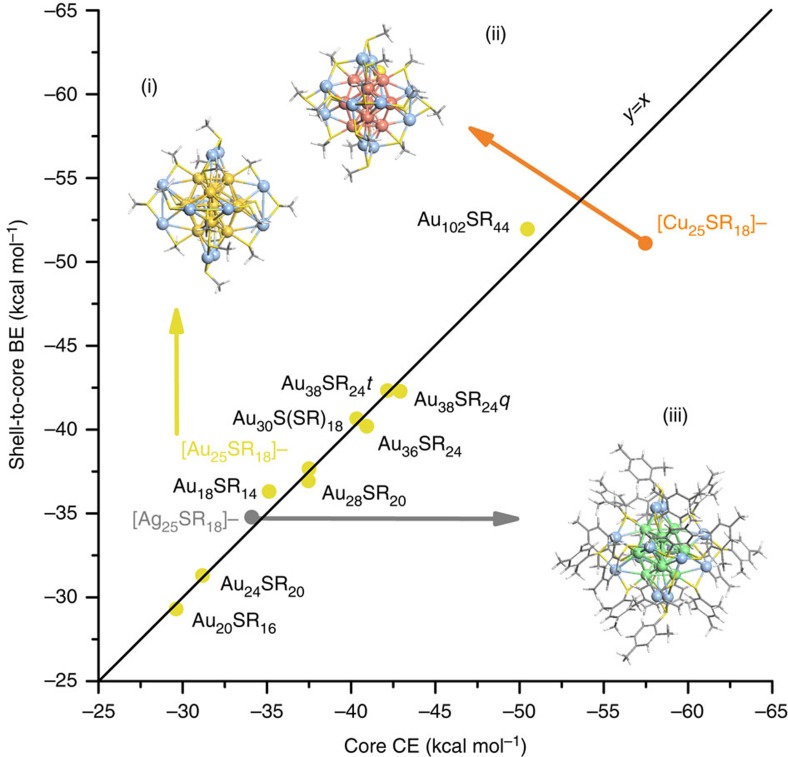
Parity between core cohesive energy and the shell-to-core BE.The corresponding structures of the Aun(SR)m NCs are presented in Fig. 1 except from the optimized structures of (i) [Au25SR18]− (ref. 31), (ii) [Cu25SR18]− and (iii) [Ag25(SPhMe2)18]− (ref. 36) NCs, which are shown as insets in the graph. For i–iii, nc=13 metal atoms (Au/Cu/Ag) and nShellInt=12 as in Fig. 1. The shell metal atoms are shown in blue, whereas, the Cu and Ag core metal atoms are shown in red and green, respectively. Here, all the Au and Ag NCs reported have been experimentally determined. The Cu NC structure is hypothetical, optimized from the Au NC analogous
structure (i).